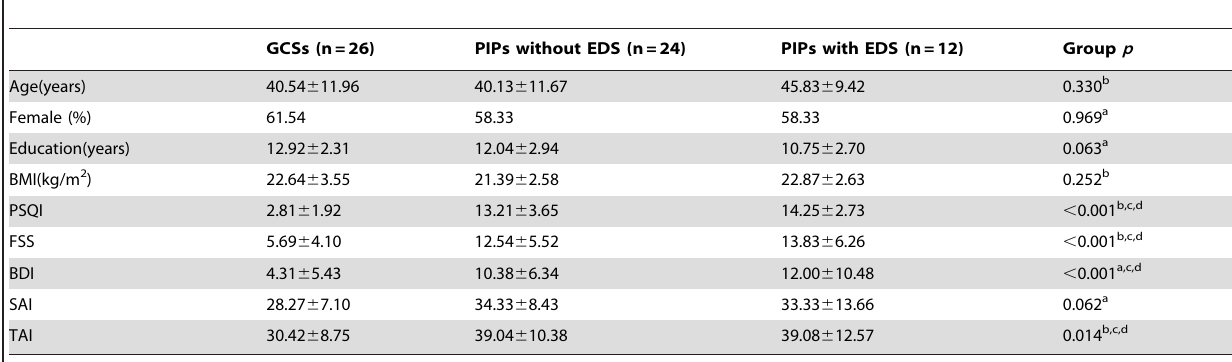
Table 1. Descriptive data and daytime symptoms in GSCs, PIPs with EDS and PIPs without EDS.